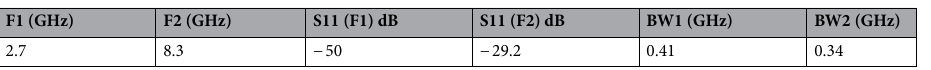
Table 1. Electrical properties of Antenna1